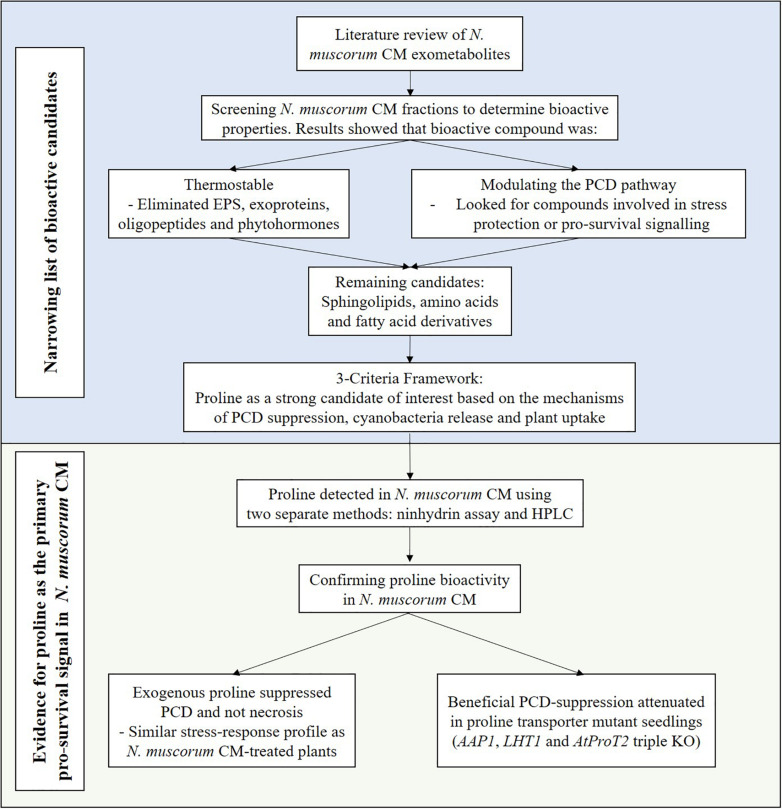
Workflow for identifying the pro-survival signal in N. muscorum CM.